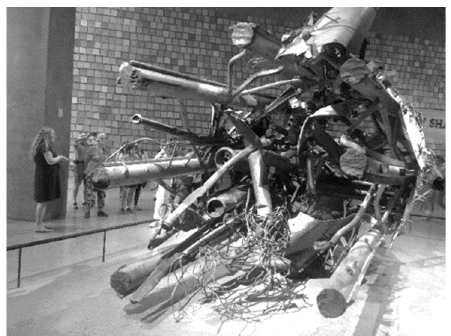
Figure 17. The burnt elevator motor cable at the 9/11 Memorial.